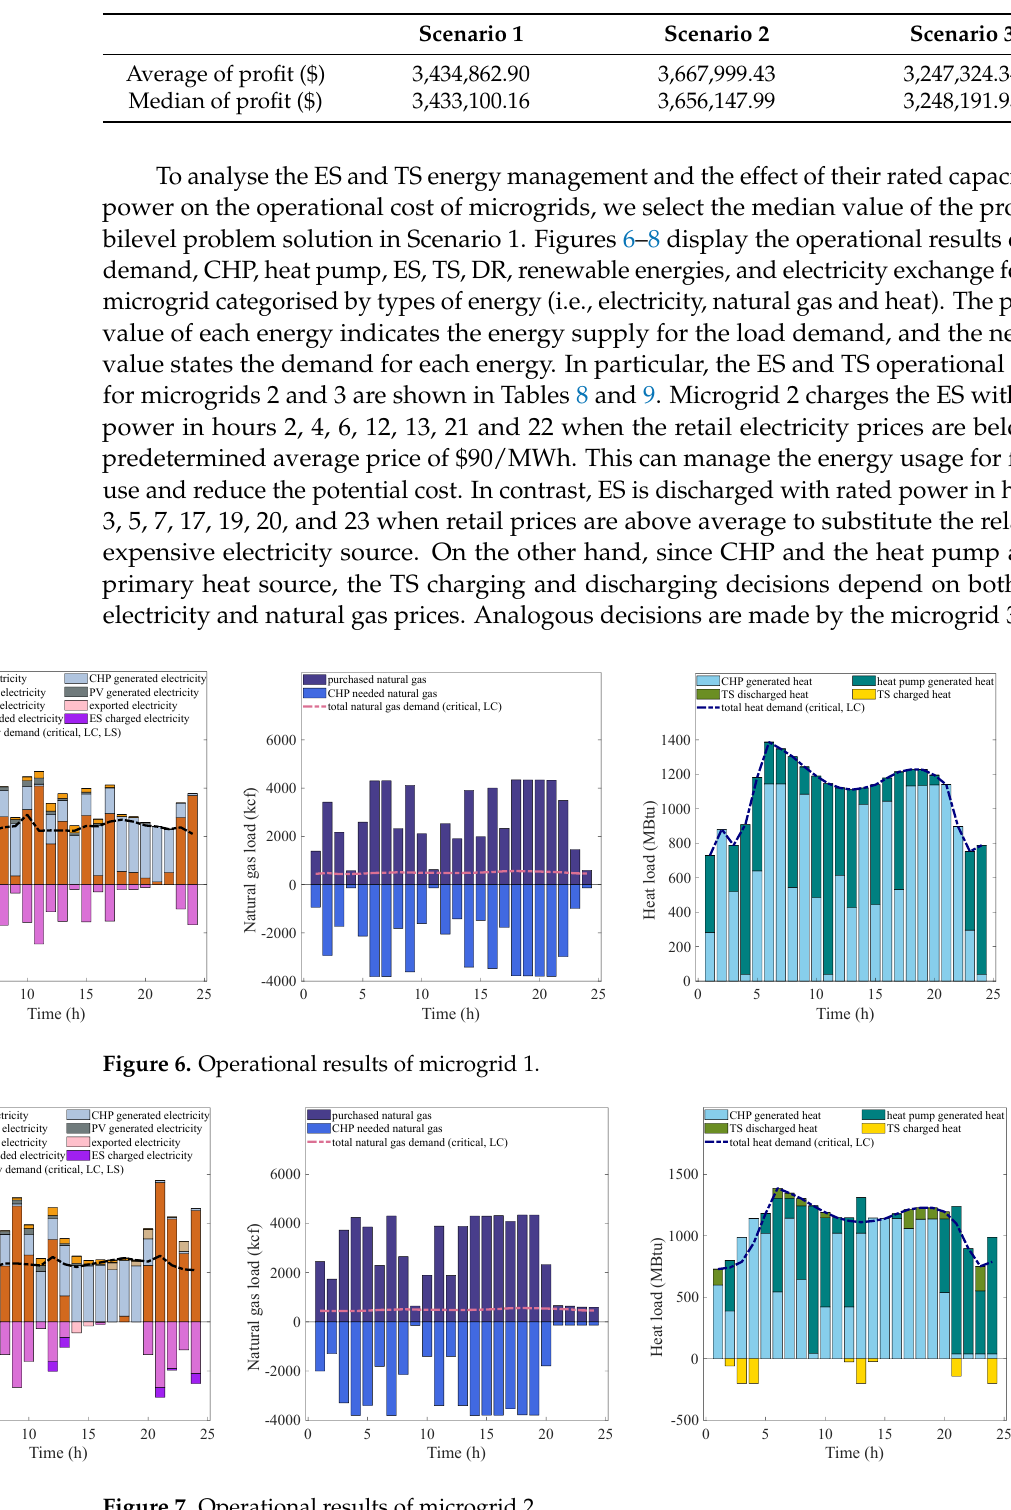
Table 7. Profit of retailer with different scenarios.